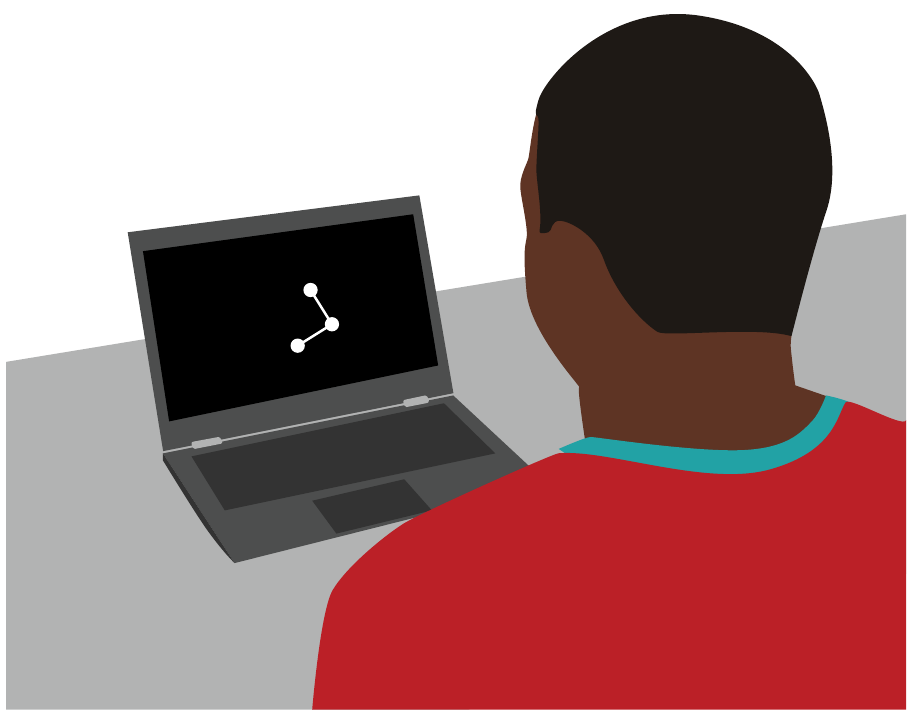
Fig 1. Set up for Experiments 1 and 2. In each trial, subjects were instructed to observe a stick-figure display of a two- link planar arm move along a closed path for 20s and then estimate its stiffness on a numeric scale from 1 (“least stiff”) to 7 (“most